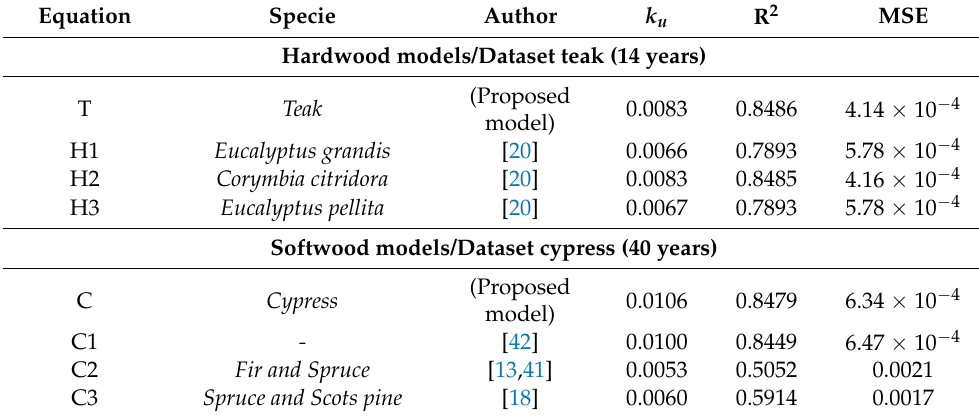
Table 3. Adjustment (R 2 and MSE ) of the proposed models versus literature models tested with the experimental teak and cypress data for the estimation of references velocity at 12% MC ( V 12 ) from velocity ( V H ) with different moisture content.